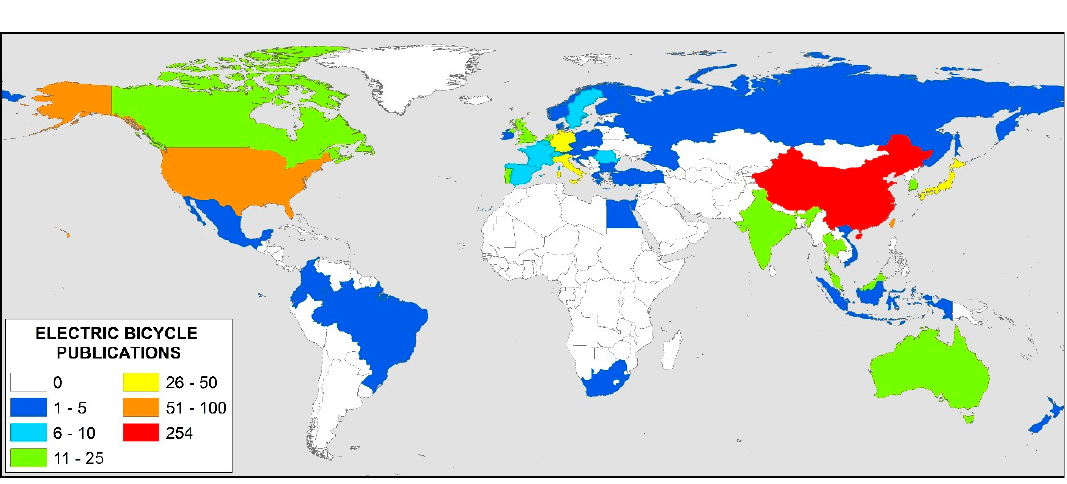
Figure 5. Geographic distribution by countries of scientific production in relation to electric bicycles.